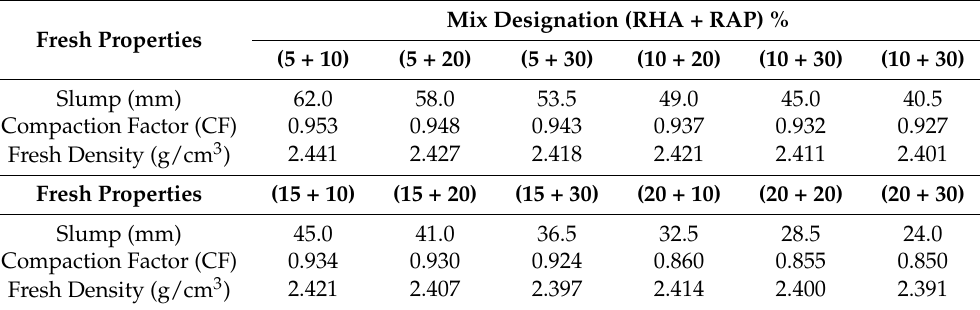
Table 8. Fresh properties of both RHA and RAP concrete mixes.